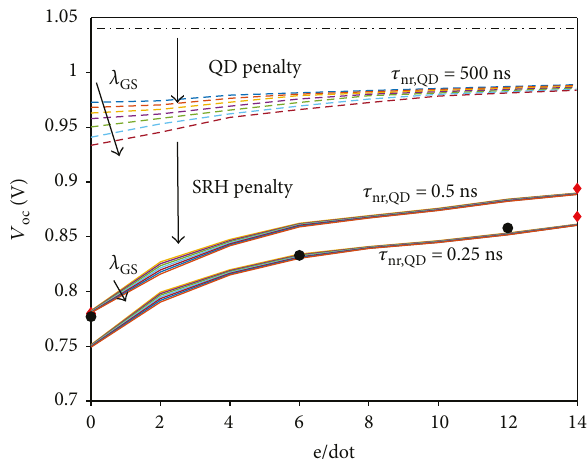
Figure 6: Analysis of V penalty in QDSC as a function of the per oc dot doping density, for di ff erent GS energy con fi nement ( λ from 990nm to 1050nm) and di ff erent minority carrier lifetime in the interdot layers ( τ ). The black dash-dot line indicates the nr,QD V of the reference bulk GaAs cell. The red bullet indicates oc experimental data in this work. The black bullet indicates experimental data from Lam et al.